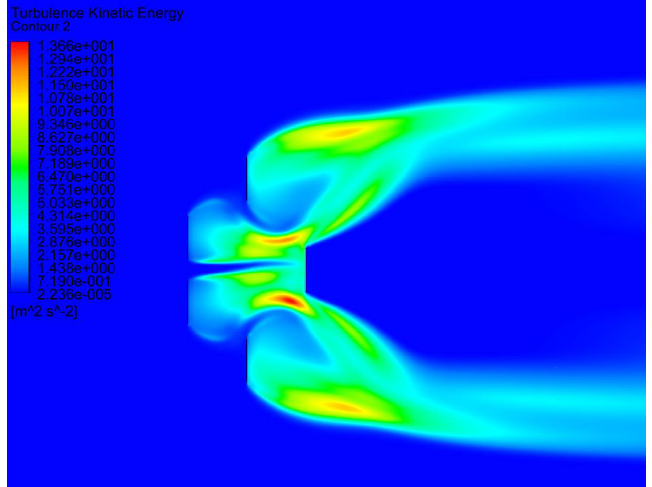
Figure 12. Turbulent kinetic energy contours of the pentagon platform.